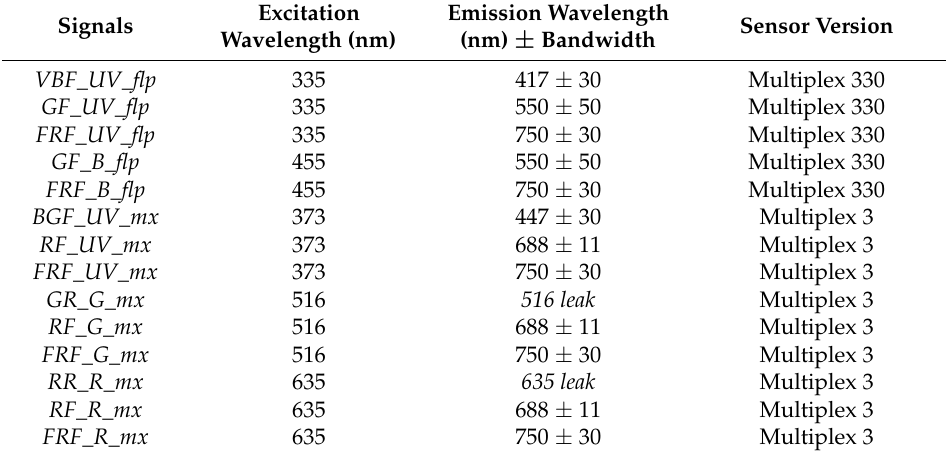
Table 1. Description of the Multiplex signals used in this study (measurement unit: mV).